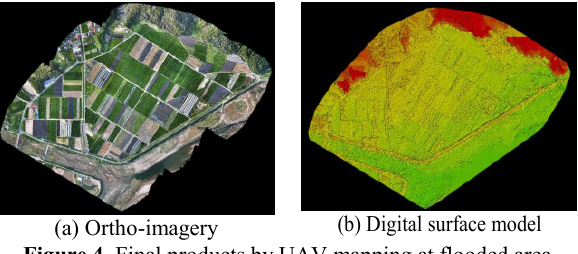
aerial photogrammetry-based data processing